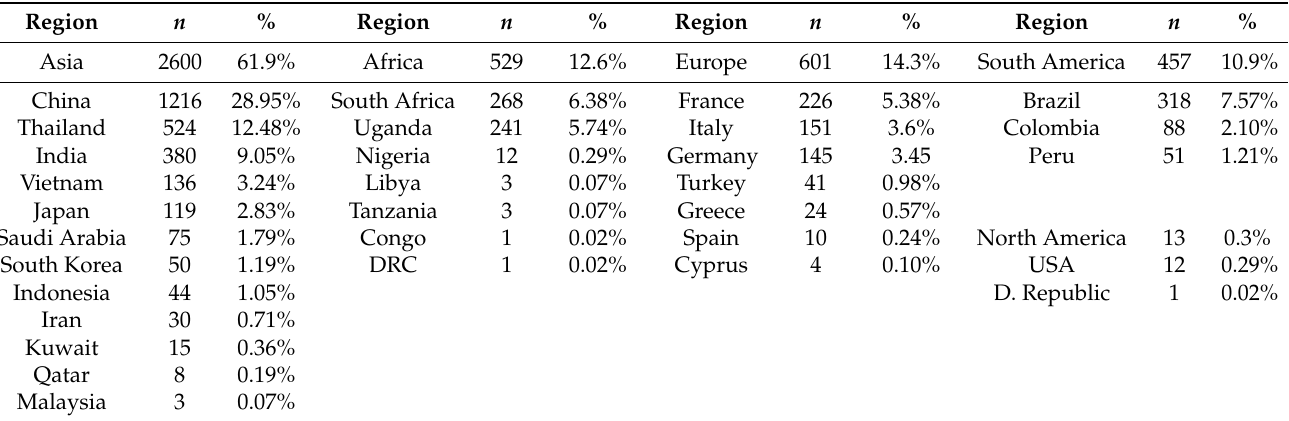
Table 1. Summary of the geographic distributions of isolates of the C. neoformans species complex genotyped using the ISHAM multilocus sequence typing